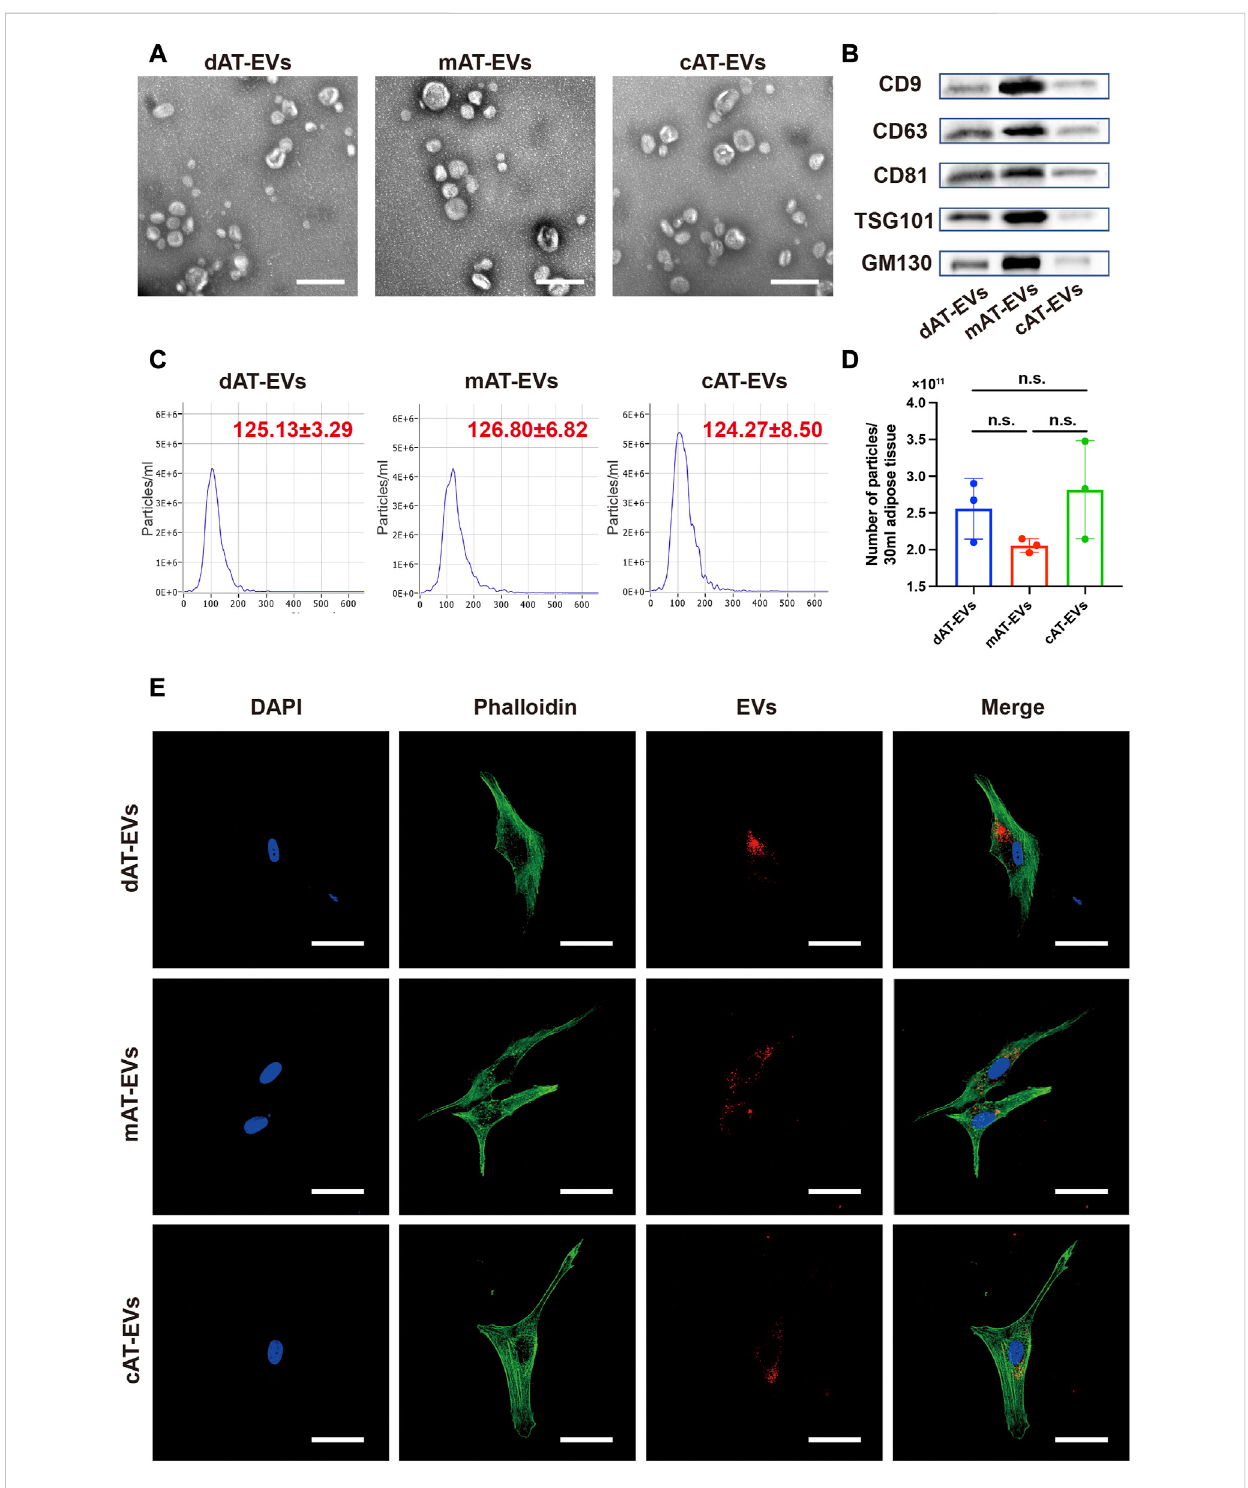
FIGURE 2 CharacterizationofAT-EVs (A) MorphologyofAT-EVs,observedbytransmissionelectronmicroscopy(TEM).Scalebars=200 nm. (B) Expression of the EV-related markers (CD9, CD63, CD81, TSG101, and GM130) in AT-EVs, as determined by Western blotting. (C) Particle diameter distribution of dAT- EVs (125.13 ± 3.29 nm), mAT-EVs (126.80 ± 6.82 nm), and cAT-EVs (124.27 ± 8.50 nm), determined by nanoparticle tracking analysis (NTA). (D) Particle numbers of AT-EVs derived from 30 mL adipose tissue, measured using NTA. n = 3, n. s. no signi fi cant difference observed between groups (E) Immuno fl uorescence staining shows that AT-EVs were internalized by human dermal fi broblasts (HDF), after 12 h incubation. Scale bar = 50 μ